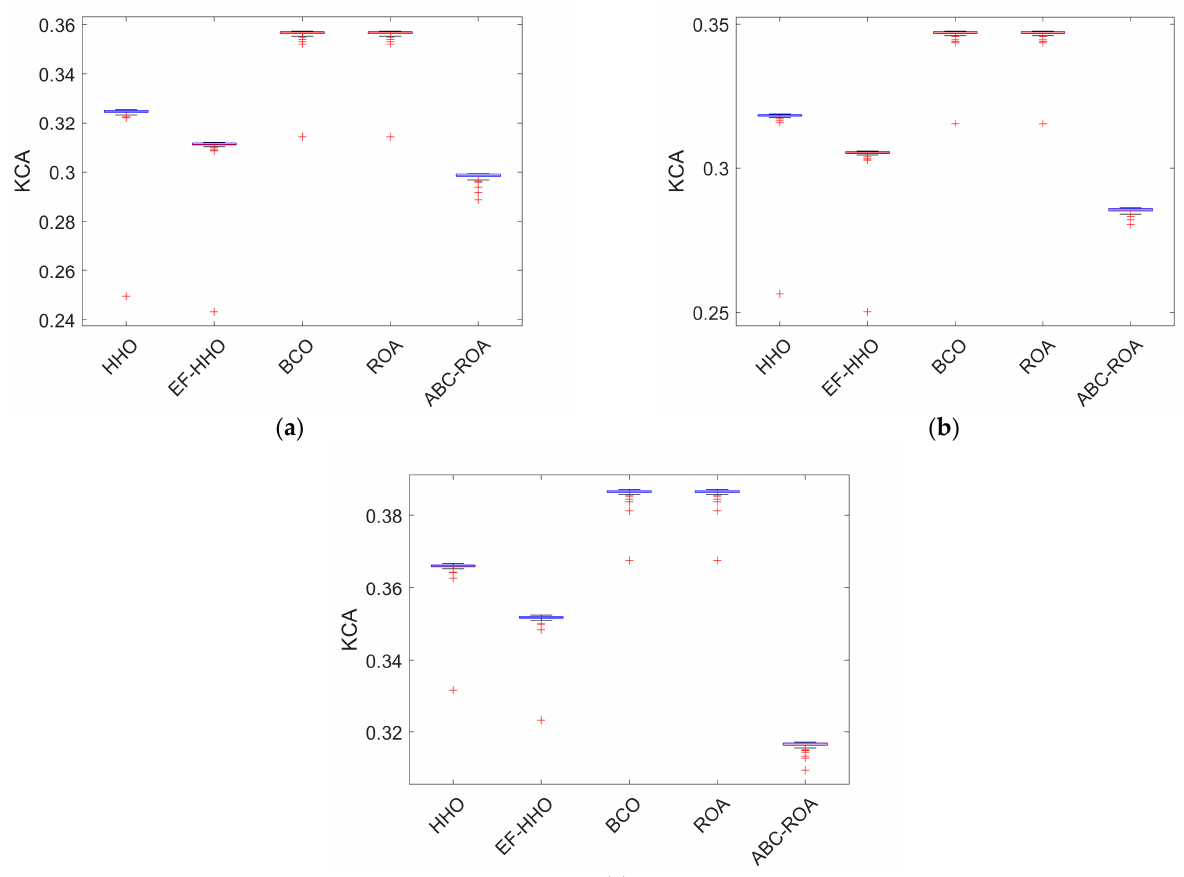
Figure 12. Effectiveness analysis of the implemented ABC-ROA based privacy preservation model using KCA in terms of ( a ) dataset 1, ( b ) dataset 2, and ( c ) dataset 3